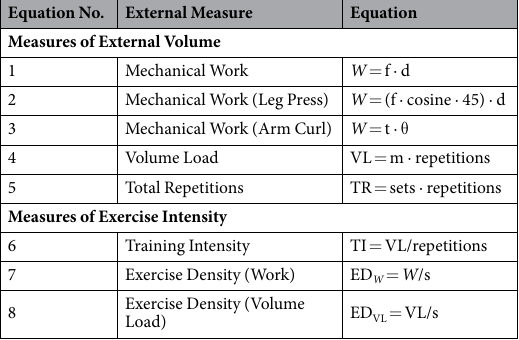
Table 1. Equations used to calculate external volume and intensity. Note . W = mechanical work, f = force, d = displacement, t = torque, θ = theta (angle in radians), VL = volume load, m = mass, TR = total repetitions, TI = training intensity, ED = exercise density, s =